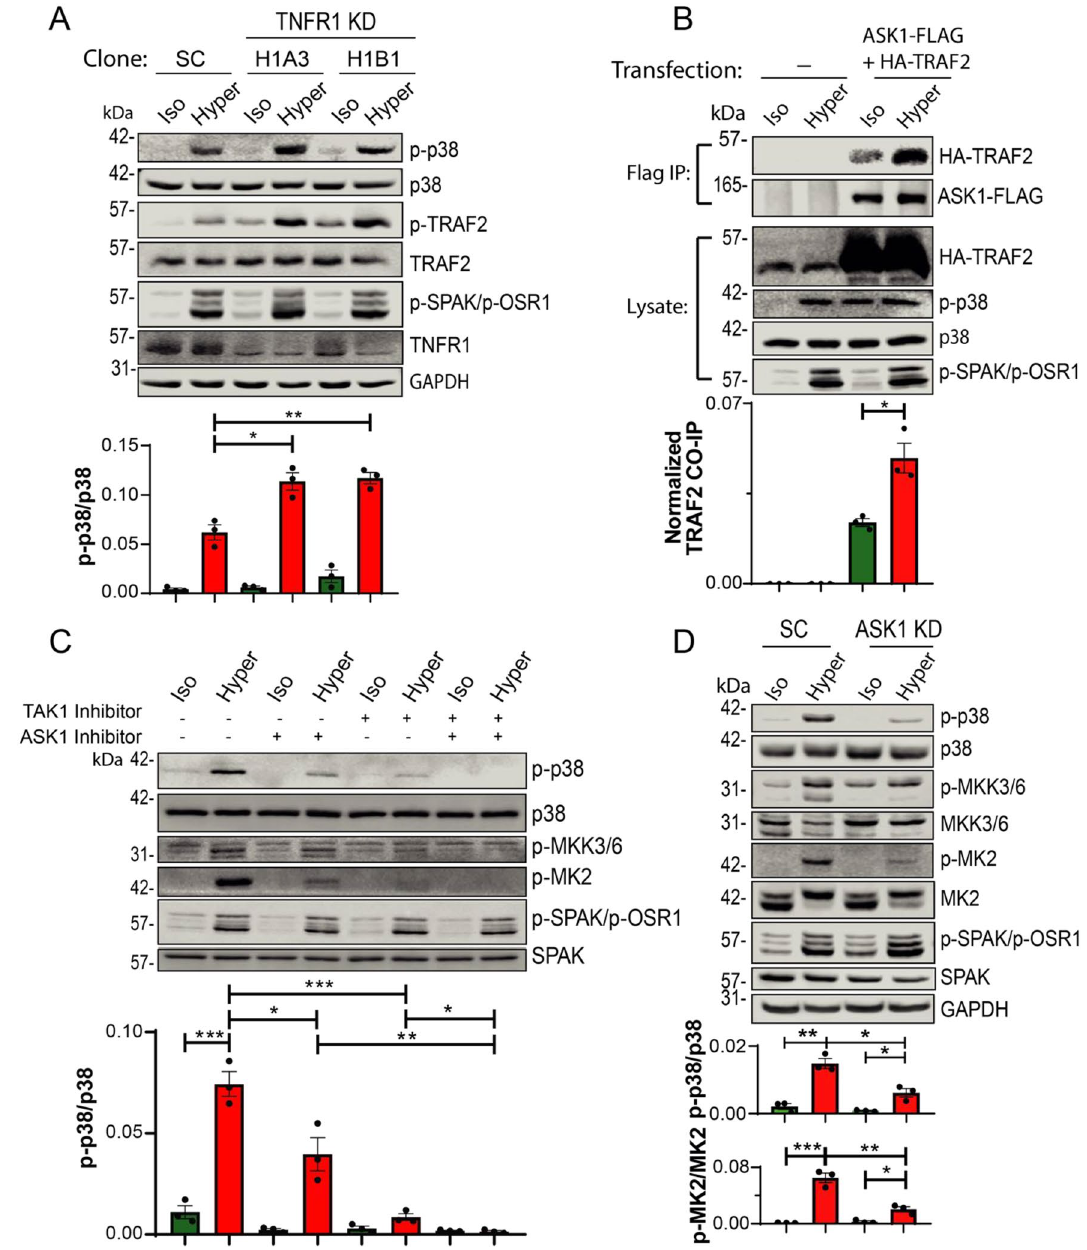
Figure 2. MAP3Ks, ASK1 and TAK1 induce p38 activation in HeLa cells upon hyperosmotic treatment. ( A ) Scramble Control (SC) or two different TNFR1 stable knockdown HeLa cell lines (H1A3, H1B1) were treated with iso-osmotic (Iso) or hyper-osmotic (Hyper) NaCl solutions for 15 min. ( B ) HeLa cells were transfected (or not) with ASK1-FLAG and HA-TRAF2 for 48 h and treated with iso- or hyper- osmotic NaCl solutions. ASK1- FLAG was immunoprecipitated with FLAG affinity beads and TRAF2 co-immunoprecipitation was determined by immunoblotting for TRAF2. ( C ) HeLa cells were treated (or not) with 10 µM GS-444217 (ASK1 inhibitor) for 2 h, 1 µM 5Z-7-Oxozeanol (TAK1 inhibitor) for 1 h, or both inhibitors, followed by incubation with iso- or hyper- osmotic NaCl solutions for 15 min in the absence/presence of GS-444217 or 5Z-7-Oxozeanol, where indicated. Quantification of active p38 (p-p38) as well as co-immunoprecipitated (Co-IP) TRAF2 is depicted below their respective blots. ( D ) Inhibition of p38 signaling in ASK1 knockdown (KD) HeLa cells relative to scramble control (SC) cells under hyper-osmotic stress. Experiment was done similar to panel A. Quantification of active p38 (p-p38), MK2 (p-MK2) or co-immunoprecipitated (Co-IP) TRAF2 is depicted below their respective blots. All data are mean ± s.e.m, N = 3 independent experiments. Statistics as described in Fig.